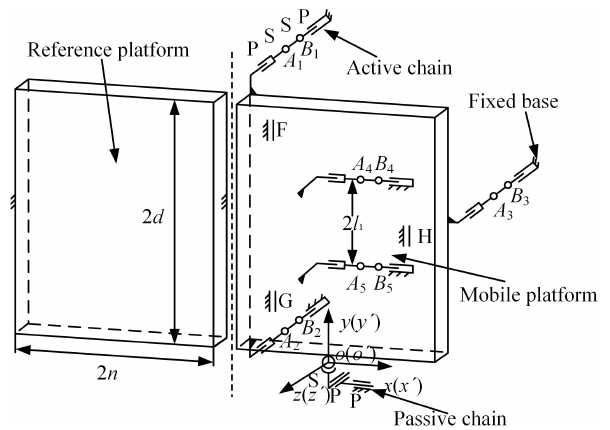
Figure 3. Sketch of grating tiling device.